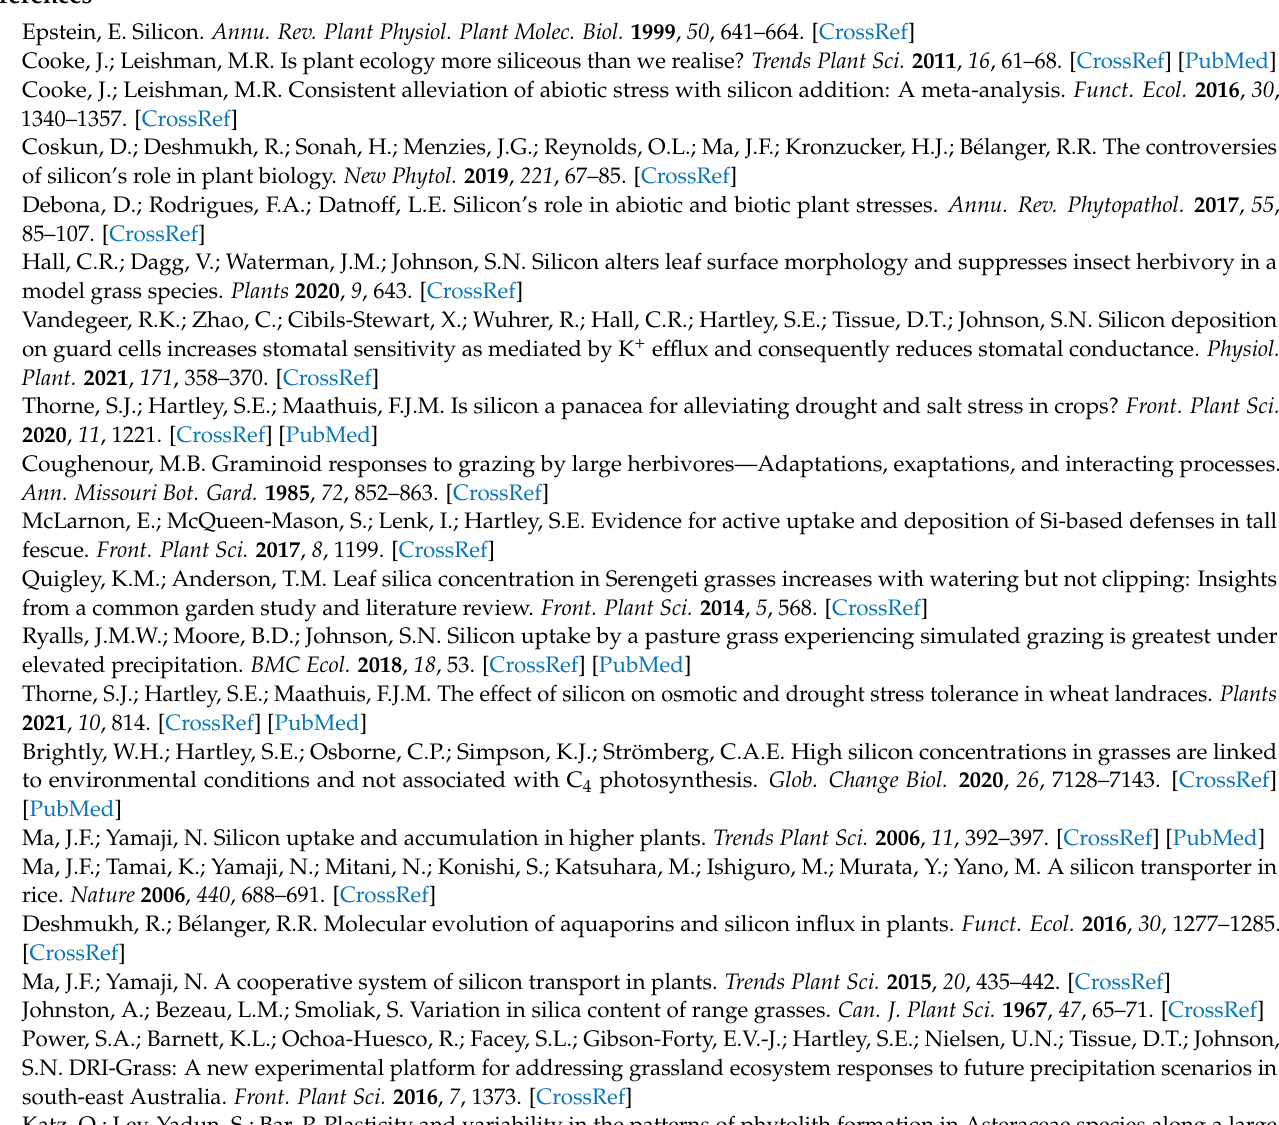
accessions; Table S4: Characteristics of the homogenised soil used in the common garden